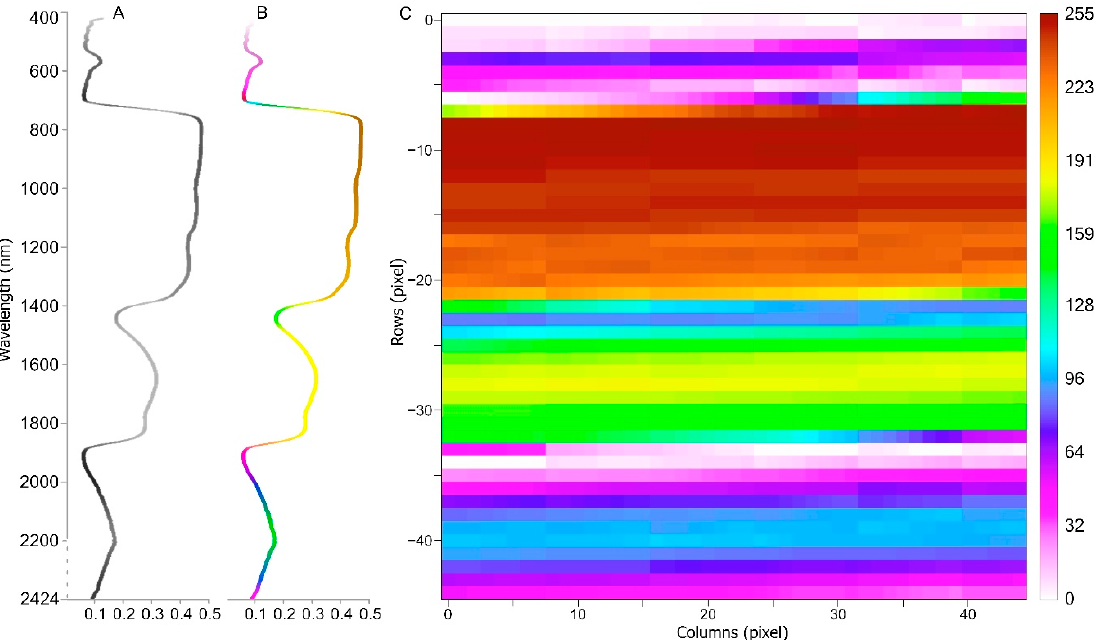
Figure 3. Sample of one reflectance structure data item reshaped into a 45 × 45 shape image. ( A ): original reflectance structure data; ( B ): colorized reflectance structure data; ( C ): reshaped 2D image data. Reflectance wavelengths range from 400–2424 nm, and 2025 features are selected. Generated origin image is greyscaled, and the sample image is colorized to better understand each part of the reflectance. Reflectance values in the range 0–1 are reshaped into the grey image, with integer values scaled to 0–255. Hence, row 0 and column 0 represent 400 nm wavelength scaled value, and row − 44 and column 44 represent 2424